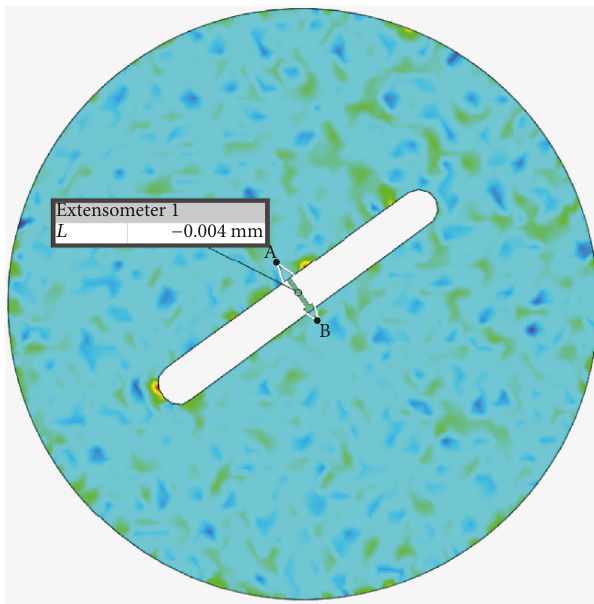
Figure 11: “Extensometer” constructed in GOM Correlate software.